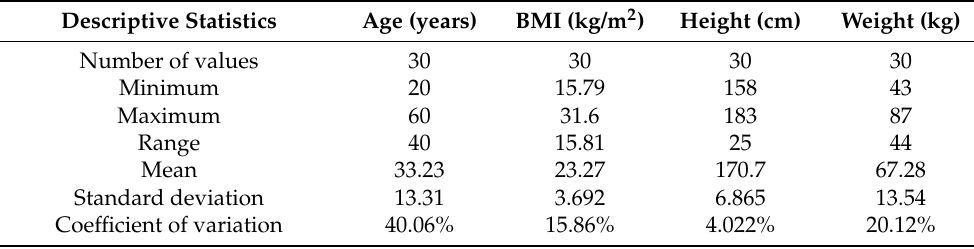
Table 1. Descriptive data of the sample.